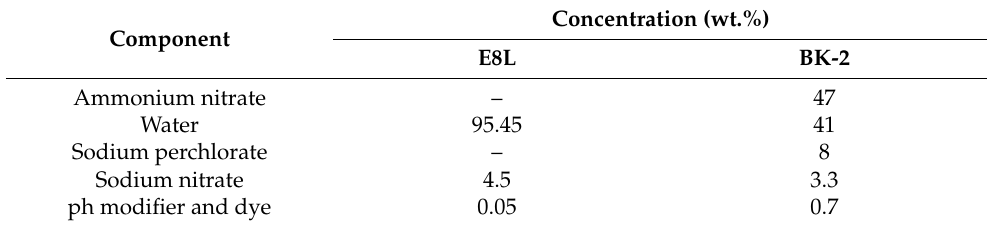
Table 1. Tested sensitizing agent formulations.